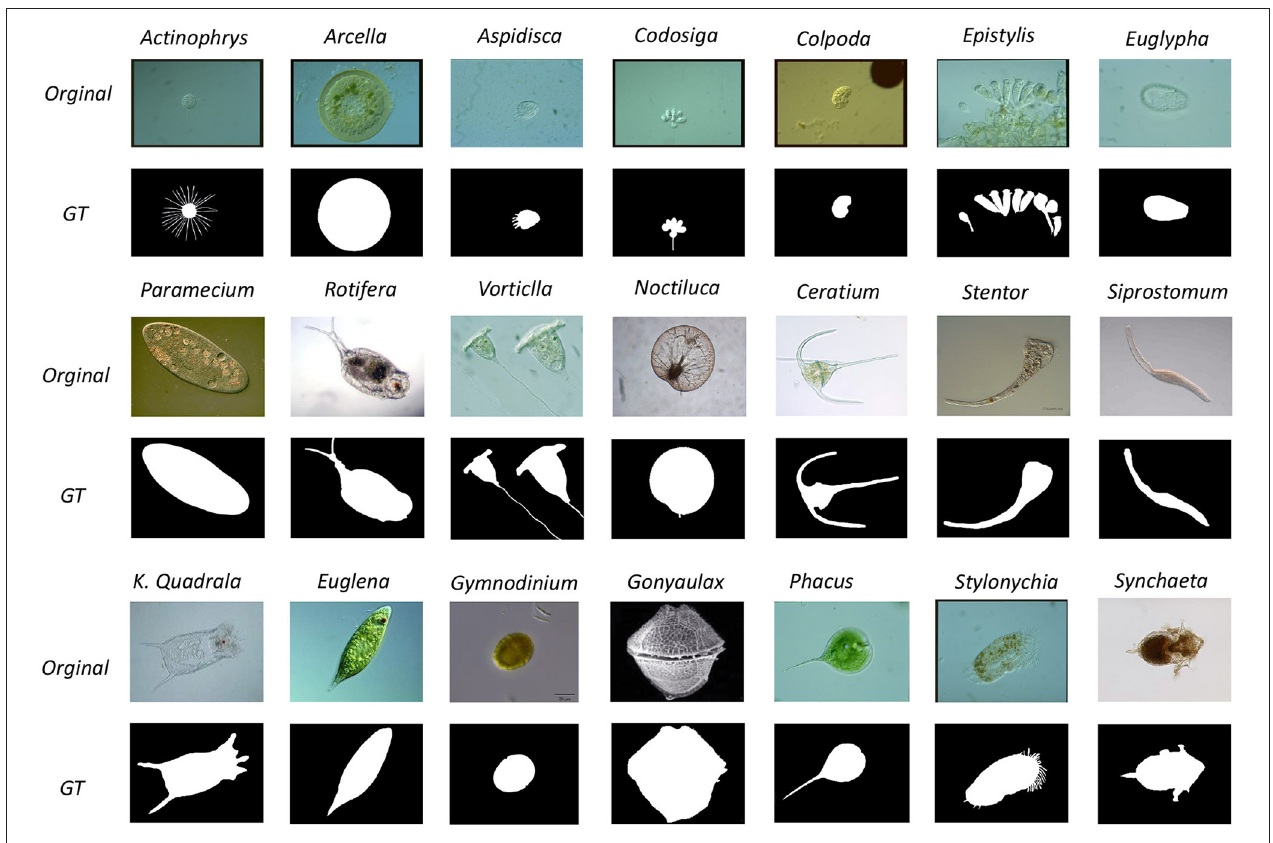
FIGURE 1 | An example of EMDS-6, including original images and GT images.